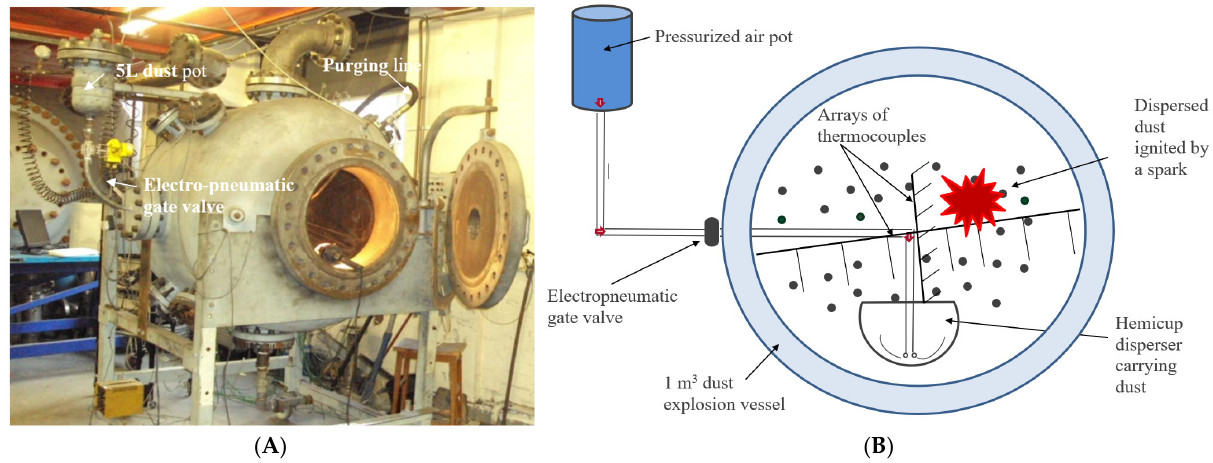
Figure 2. Modified ISO 1 m 3 vessel (( A )—a picture of the vessel; ( B )—a diagram of the experimental rig).